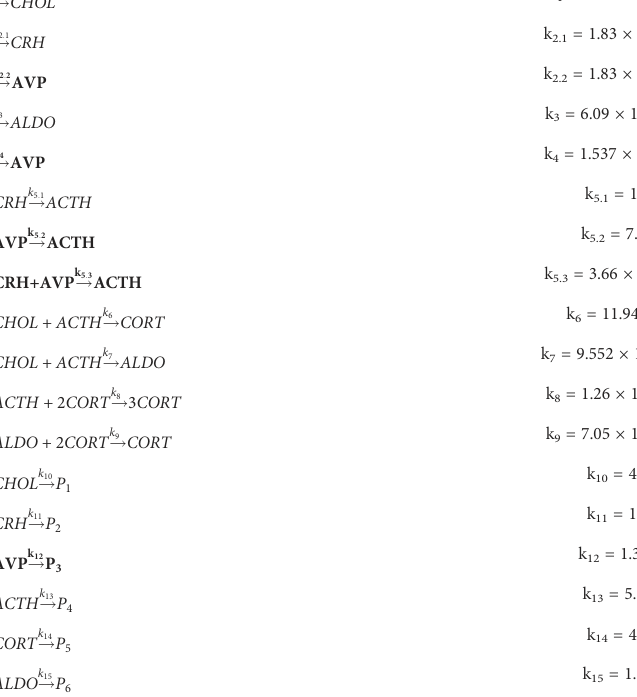
TABLE 1 The extended model of the HPA axis activity in humans with incorporated arginine vasopressin (AVP) as an additional dynamic variable; reaction steps associated with AVP are given in bold. ! k 1